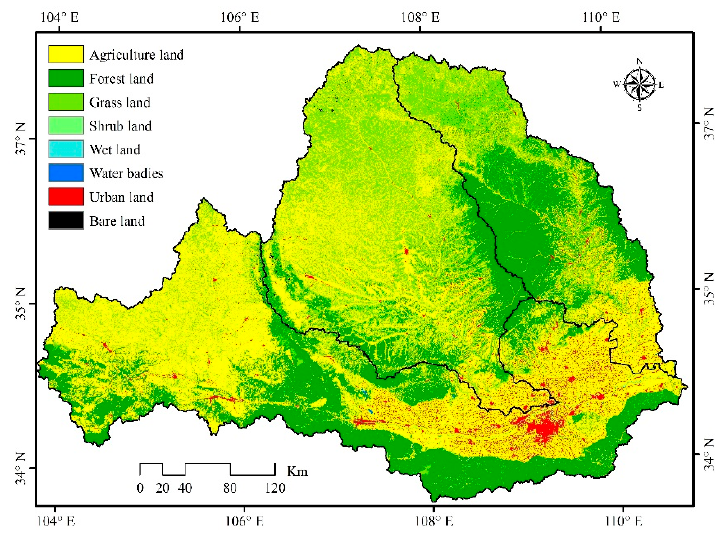
Figure 3. Land use types of the Wei River basin.